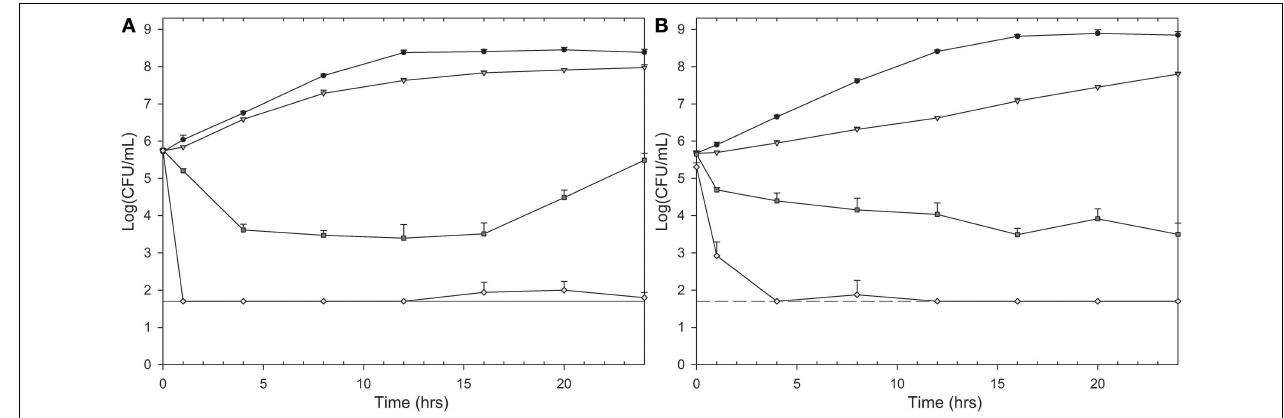
FIGURE 2 | Time-kill curves of isoeugenol’s effect on E. coli (A) and L. innocua (B) cell viability. Cells were treated with isoeugenol at 0 (black circles), ½ × MIC (gray triangle), MIC (dark gray square), or